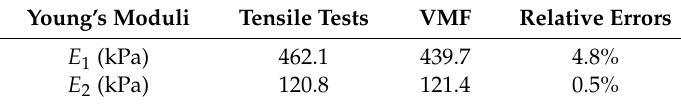
Figure 7. Strain-gradient of ε z in the z -direction. ( a ) and ( b ) are 2D strain-gradient maps of the cross-section ( c-i ) and ( c-ii ) in Figure 6 respectively plotted on their 2D OCT cross-sectional images. The purple dashed line and blue solid line indicate the estimated interface and physical interface of the two layers respectively. Table 1. The comparison between the tensile test and calculated constitutive parameters of a double-layer phantom by VFM.